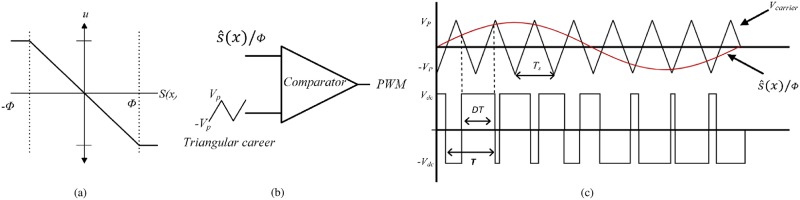
Smoothed control law using PWM (a) boundary layer (b) PWM generator (c) PWM output switching signal.